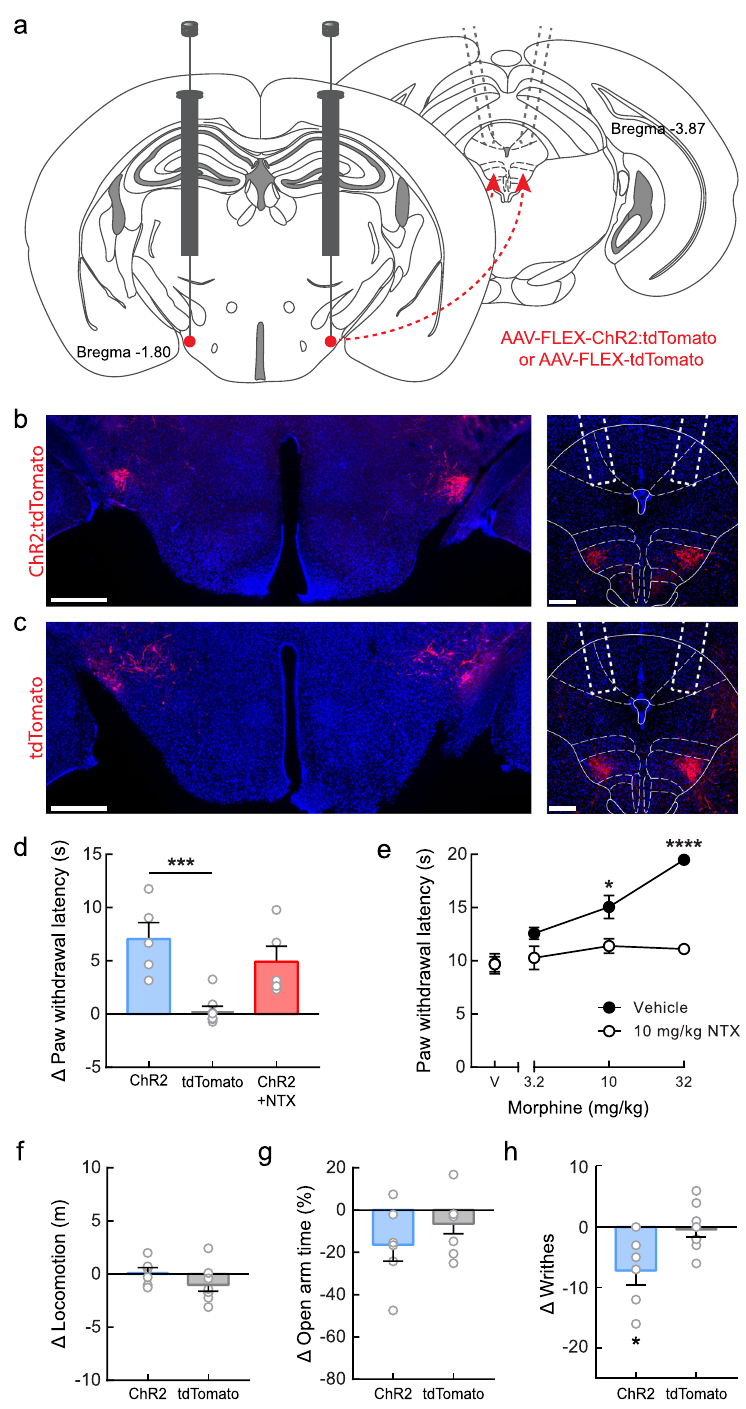
Figure 3. Activation of the LH PV → vlPAG circuitry promotes antinociception. ( a ) Schematic representation of ChR2 viral injections in the LH and optical fiber placement in the vlPAG (gray dotted lines). Schematic images modified from Franklin and Paxinos 38 . ( b , c ) Representative images showing bilateral expression of ( b ) ChR2:tdTomato (red) and ( c ) tdTomato (control; red) in LH PV neurons. Scale bars: 500 μ m. Optical fibers were implanted above the vlPAG bilaterally (white dotted lines represent average placement). Scale bars: 200 μ m. See also Supplementary Fig. S3. ( d ) Photostimulation evoked a significantly greater increase in PWL in LH PV :ChR2 → vlPAG mice (blue) compared to control LH PV :tdTomato → vlPAG mice (gray); Bonferroni multiple comparisons test, *** p = 0.0007. This increase was not significantly affected by pre-treatment with naltrexone (NTX; 10 mg/kg s.c., μ -opioid receptor antagonist), p = 0.43. ( e ) NTX (10 mg/kg s.c.) significantly attenuated morphine-induced antinociception when tested in control mice. Bonferroni post-test, * p = 0.0167, **** p < 0.0001. ( f ) Photostimulation did not evoke changes in locomotor activity in LH PV :ChR2 → vlPAG or control mice during the open field locomotion test; p = 0.20. ( g ) Photostimulation of LH PV :ChR2 → vlPAG